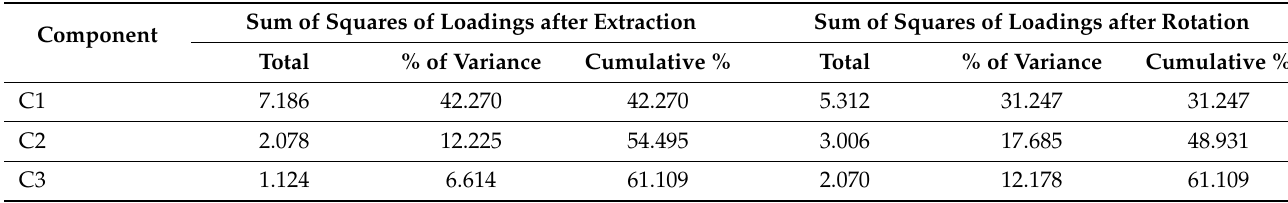
Table 4. Statistics for total explained variance.